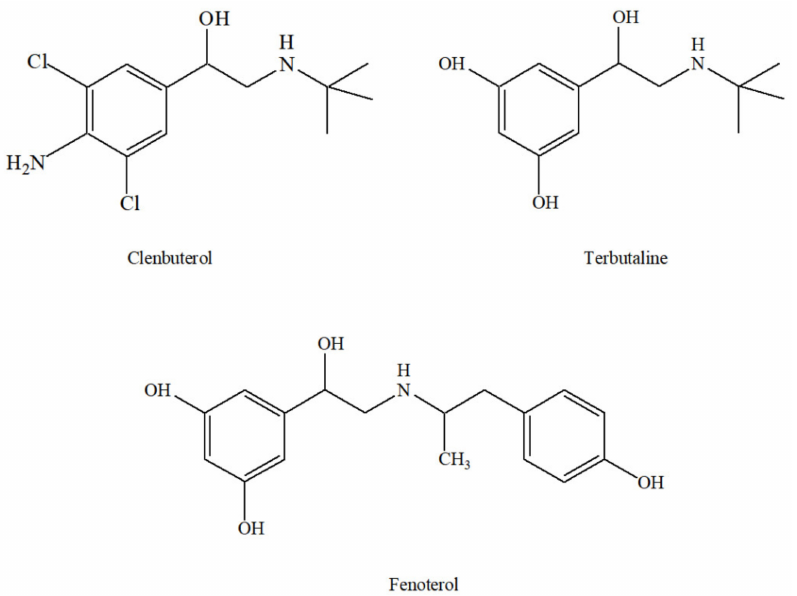
Figure 1. Chemical structures of clenbuterol, fenoterol, and terbutaline.